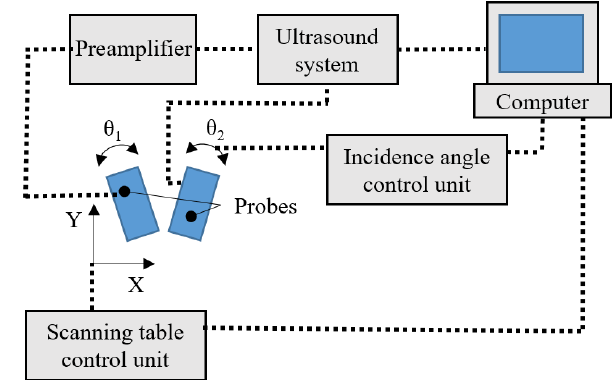
Figure 6. Schematic drawing of the test setup. The angles θ 1 and θ 2 indicate the angles of incidence between the center axis of the probe and a line normal to the specimen.